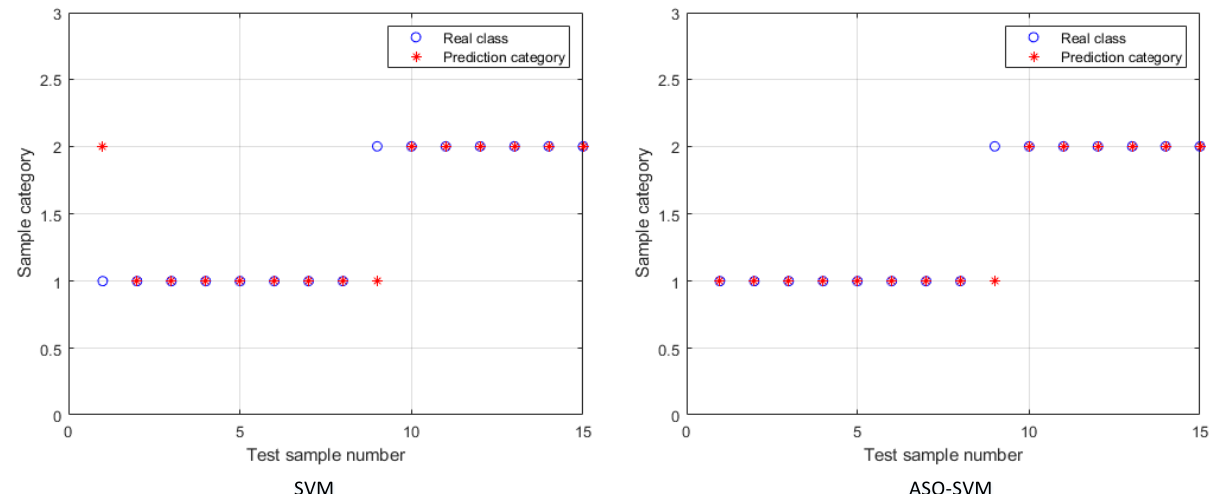
Figure 10. Fault diagnosis classification